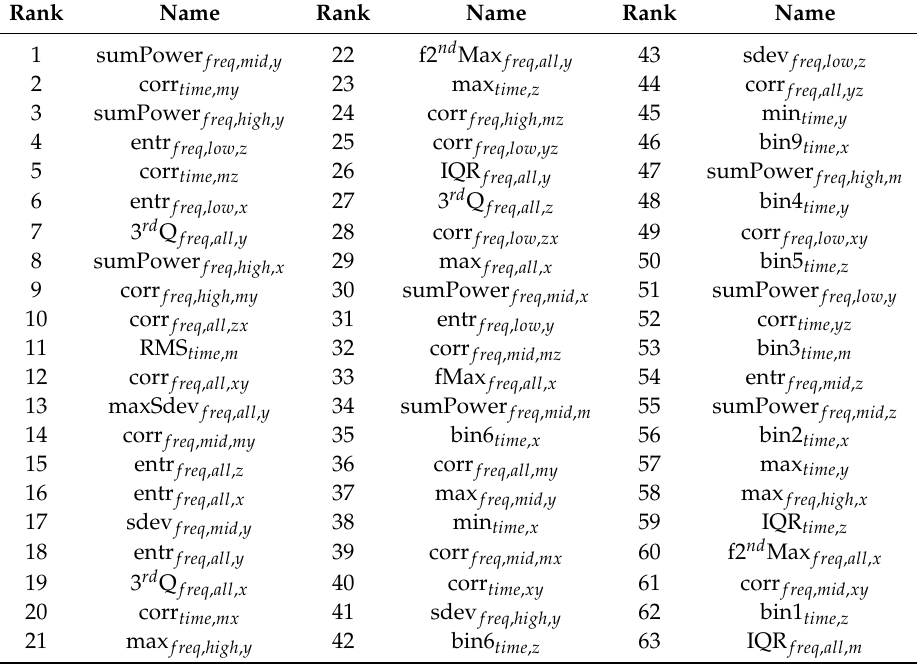
Table 8. Selected features with